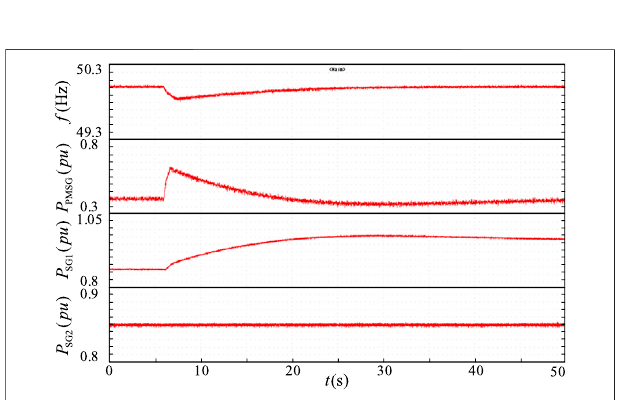
FIGURE 11 | System frequency and output power under the adaptive inertial control based on fuzzy control.